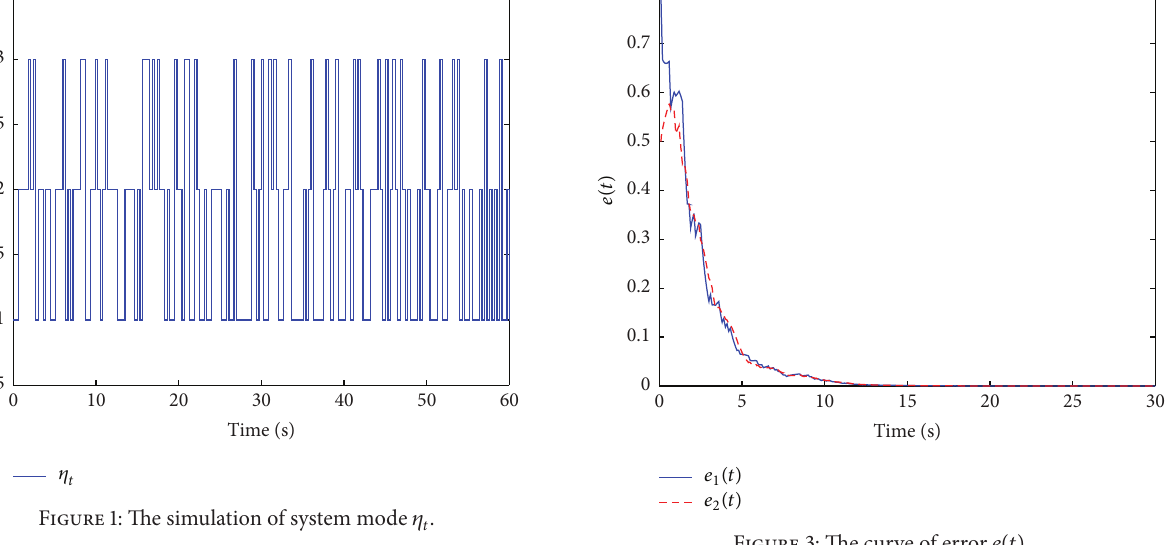
Figure 3: The curve of error 𝑒(𝑡)